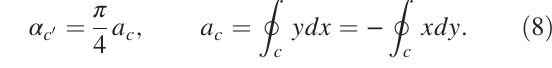
π = 2 Þ x N , and n ¼ ð n